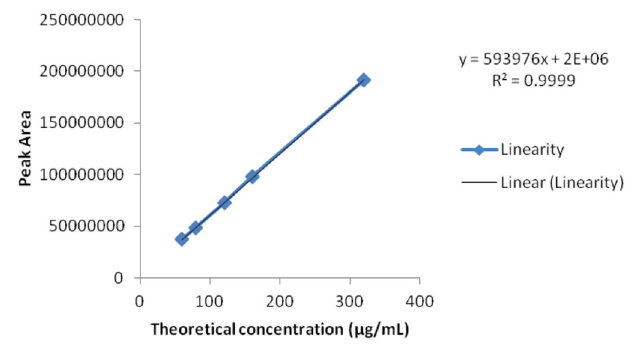
FIGURE 3 - Calibration curve of